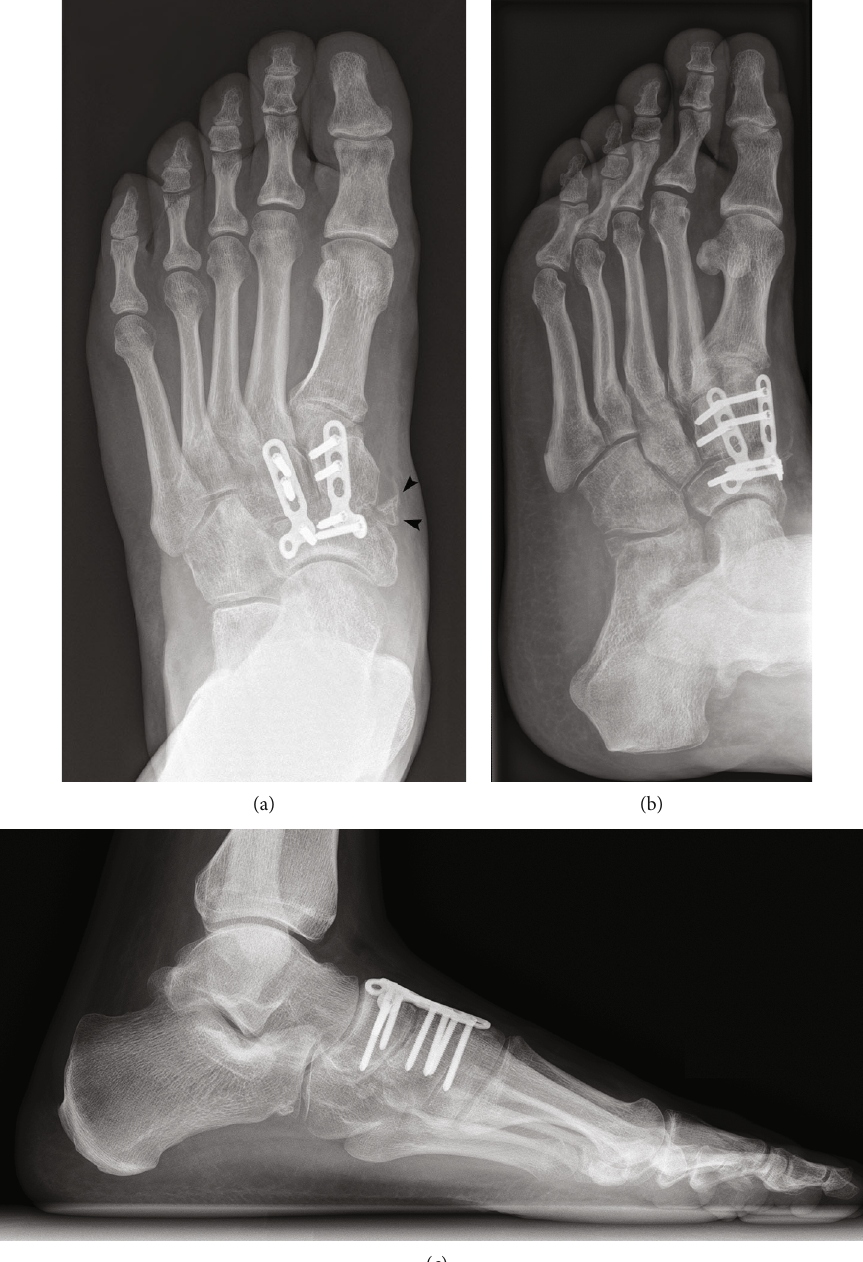
Figure 6: (a) Anteroposterior weight-bearing, (b) oblique, and (c) lateral weight-bearing X-rays of the left foot 10 months after the surgery. Black arrowheads show the osseous fragment next to the N-C1 joint responsible for the discomfort at the medial side of the